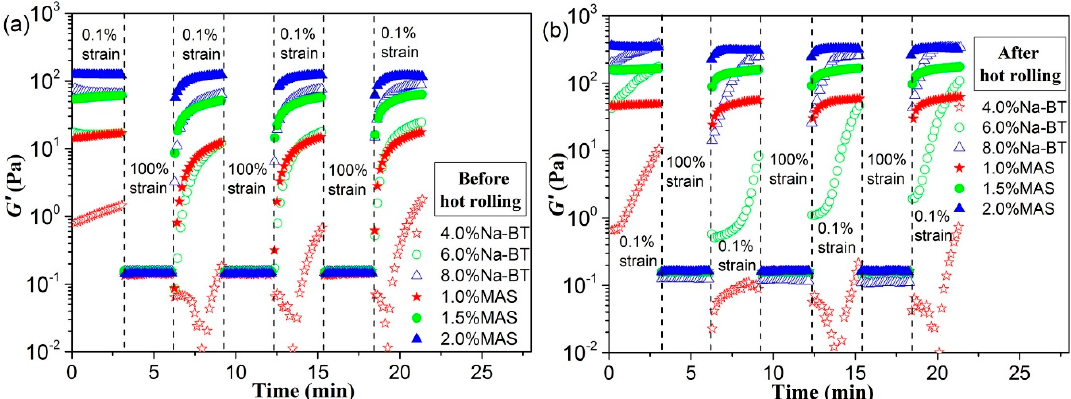
Figure 3. Changes in the viscous modulus (G’) due to strain of manganese aluminum silicate nanoparticles and sodium bentonite ( a ) before, and ( b ) after, hot rolling. The G’ of different suspension stabilized below 0.2 Pa at a high oscillatory strain (100%) and G’ increased at a low oscillatory strain (0.1%) resulting recovery of gel strength. The gel strength recovery performance increased before hot rolling; moreover, after hot rolling, the gel recovery performance of nanoparticles suspension was better compared to Na-BT suspension. Reproduced with permission from [124].